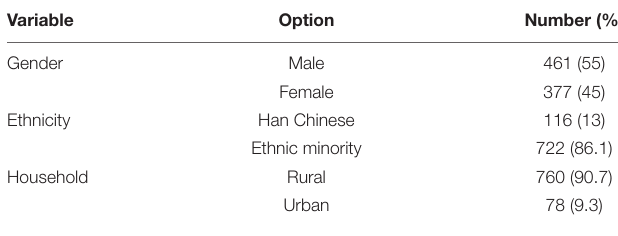
TABLE 1 | Characteristics of